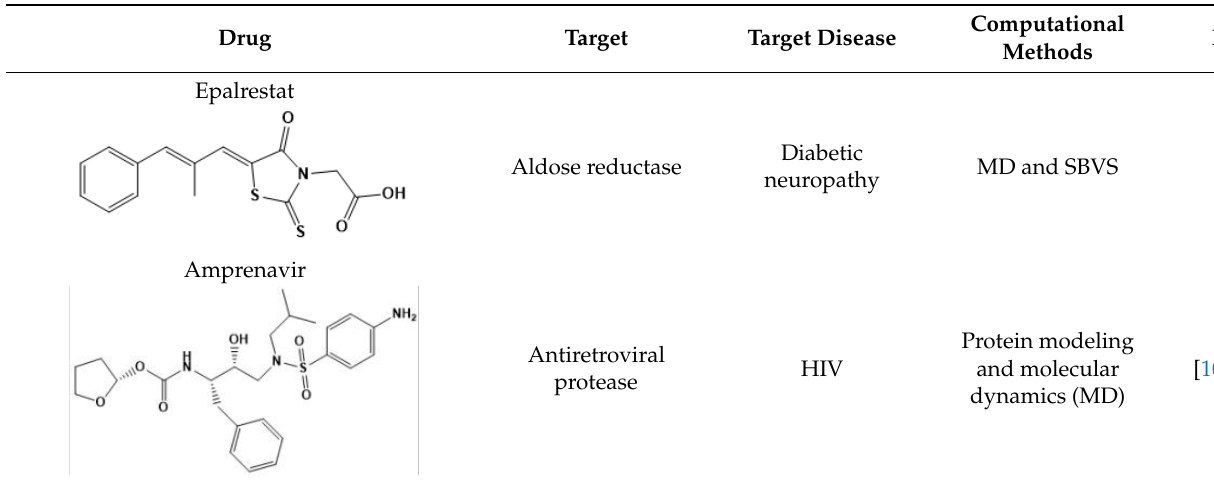
Table 3. Drug discovery by SBDD computational approaches.